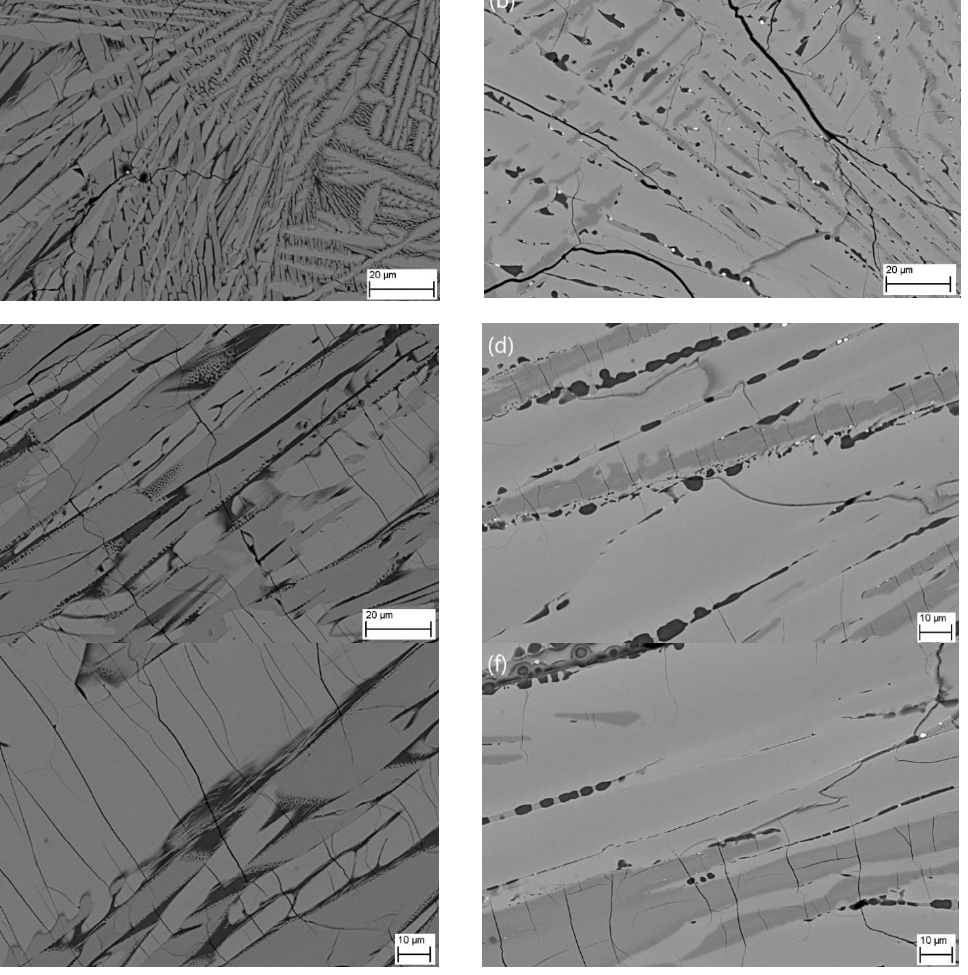
Figure 10. Microstructure for samples 7 and 10 obtained with energy dispersive X-ray microscopy (EDS) at the same magnification of 2000 × . ( a ) Outer surface of sample 7, ( b ) Outer surface of sample 10, ( c ) Center part of sample 7, ( d ) Center part of sample 10, ( e ) Inner surface of sample 7, ( f ) Inner surface of sample 10.